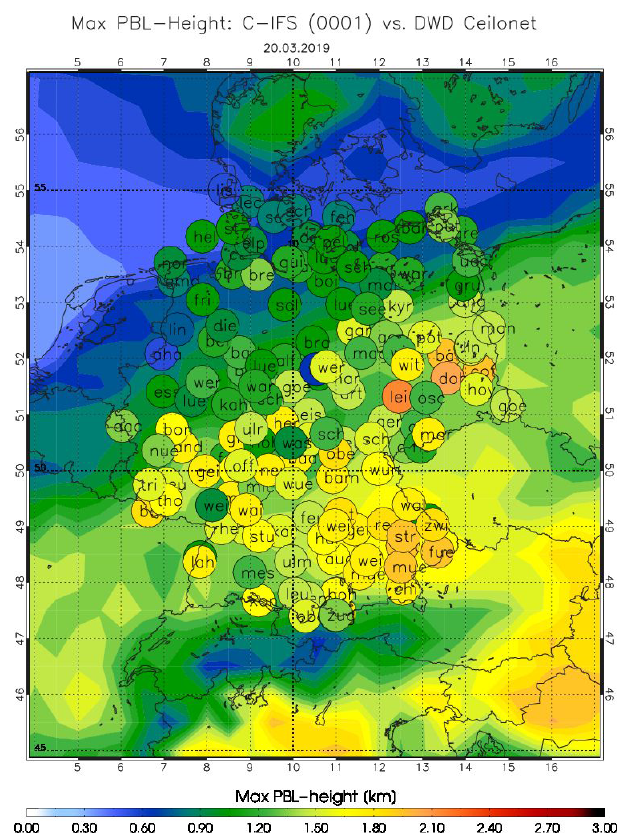
Figure 10. Map of maximum daily MLH as simulated by IFS-AER (filled contours) with MMLH at German ceilometer network sta- tions for 20 March 2019, overlain as correspondingly color-coded